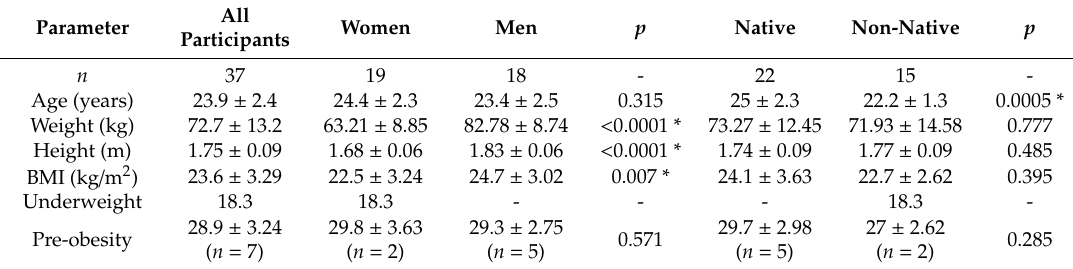
Table 1. General characteristics of study